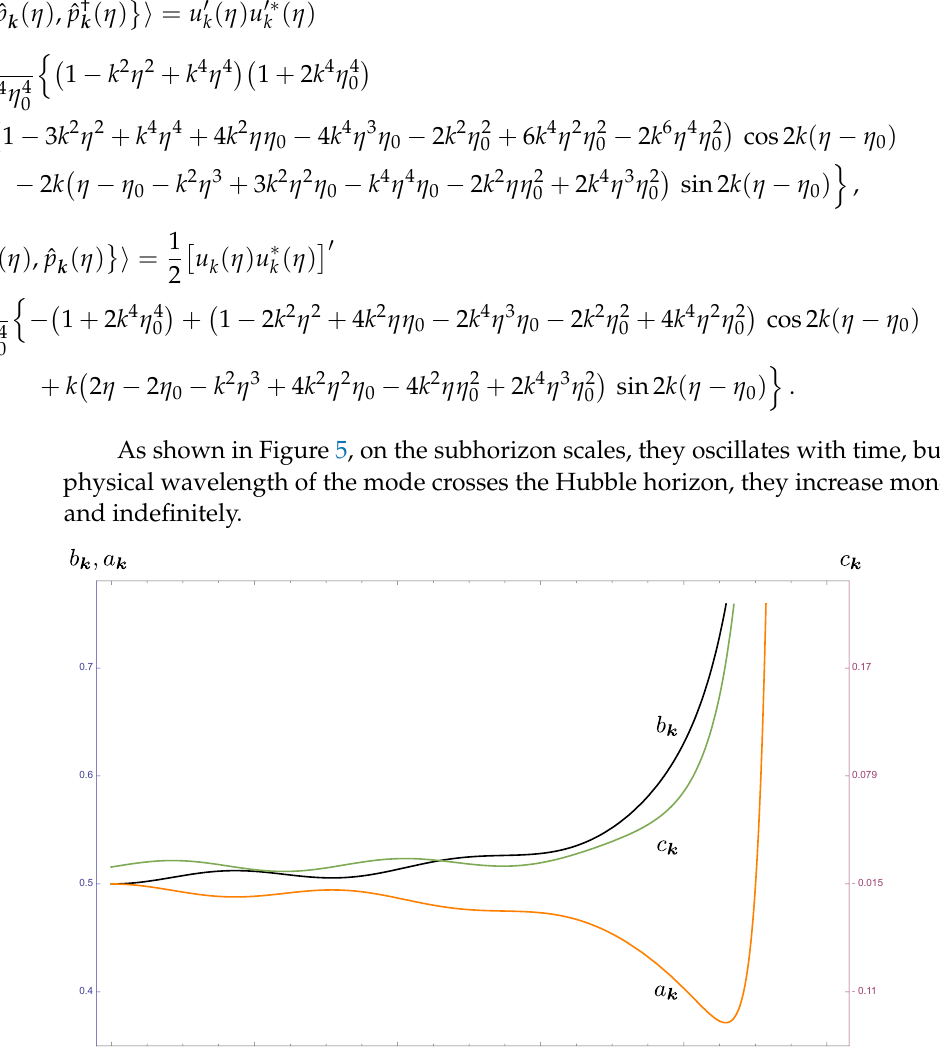
= 1 (cid:104) (cid:8) ˆ p ( η ) , ˆ p † ( η ) (cid:9) (cid:105) , and the green k k k 2 = 10 and k = 1. Hence, their 0